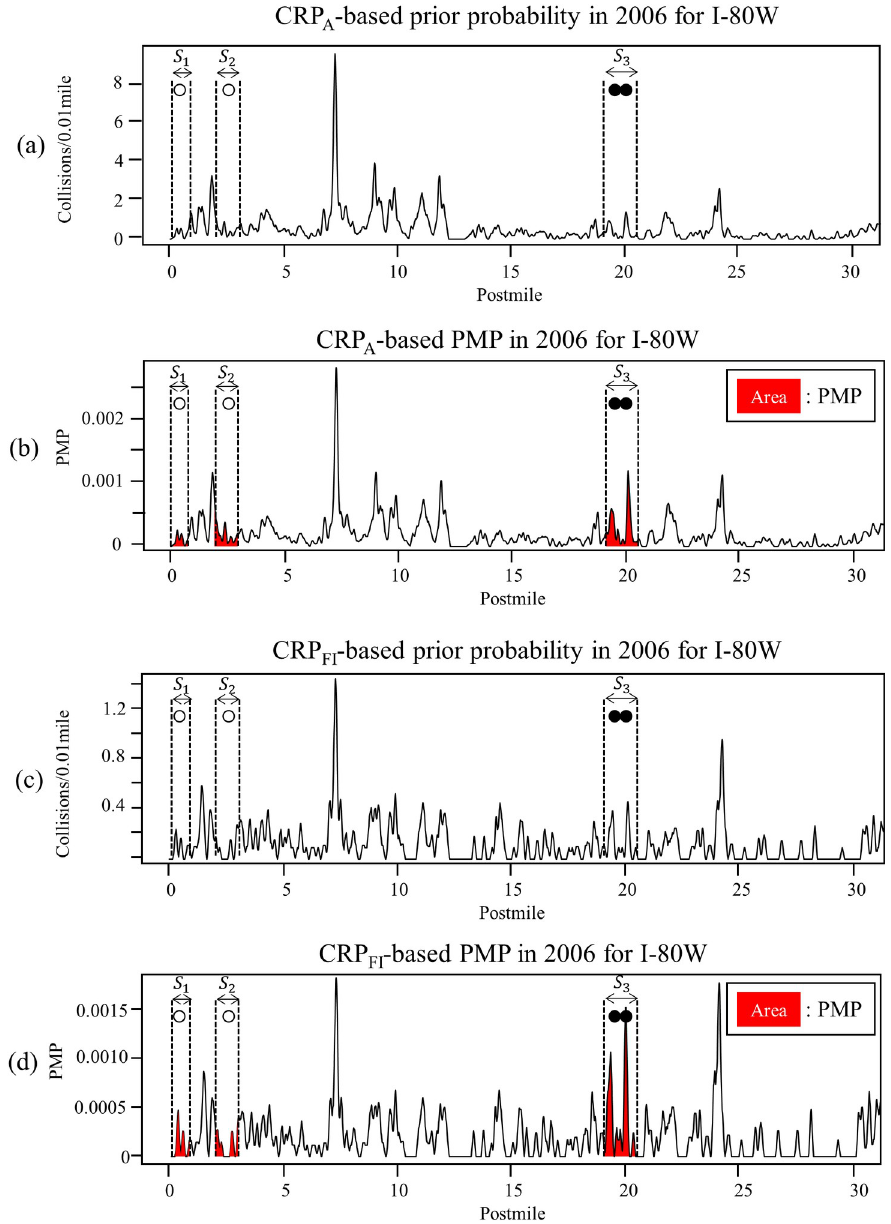
Fig 5. Results of na ï ve Bayesian approach to for I-80W in 2006: (a) CRP A -based prior probability, (b) CRP A -based PMP, (c) CRP FI -based prior probability, and (d) CRP FI -based